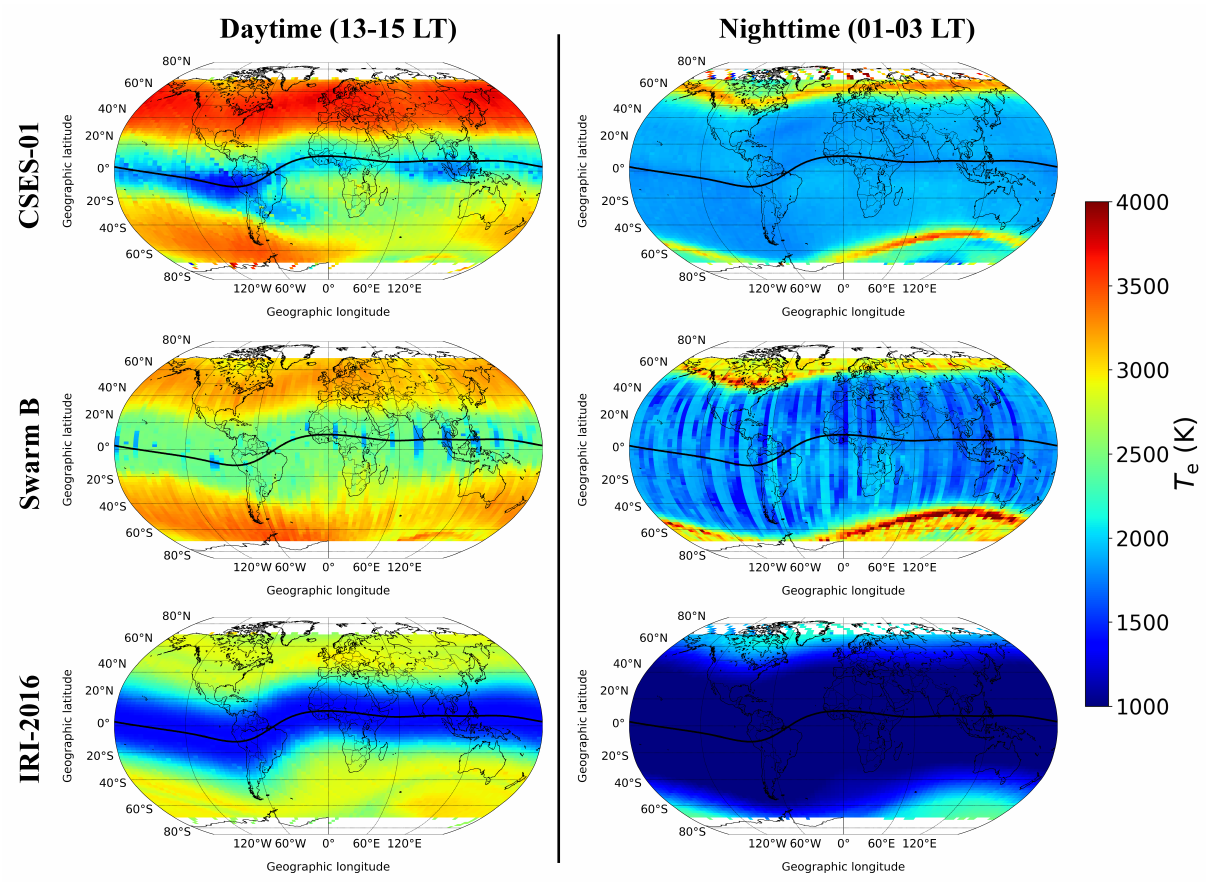
Figure 5. Maps in geodetic coordinates of electron temperature mean values measured by CSES-01 ( top panels), Swarm B ( middle panels), and modeled by IRI-2016 along CSES-01 orbits ( bottom panels). Left panels represent the daytime sector (13–15 LT), right panels denote the nighttime sector (01–03 LT). Data encompass the period from 1 January 2019 to 30 September 2021. The black thick curve in each plot represents the geomagnetic